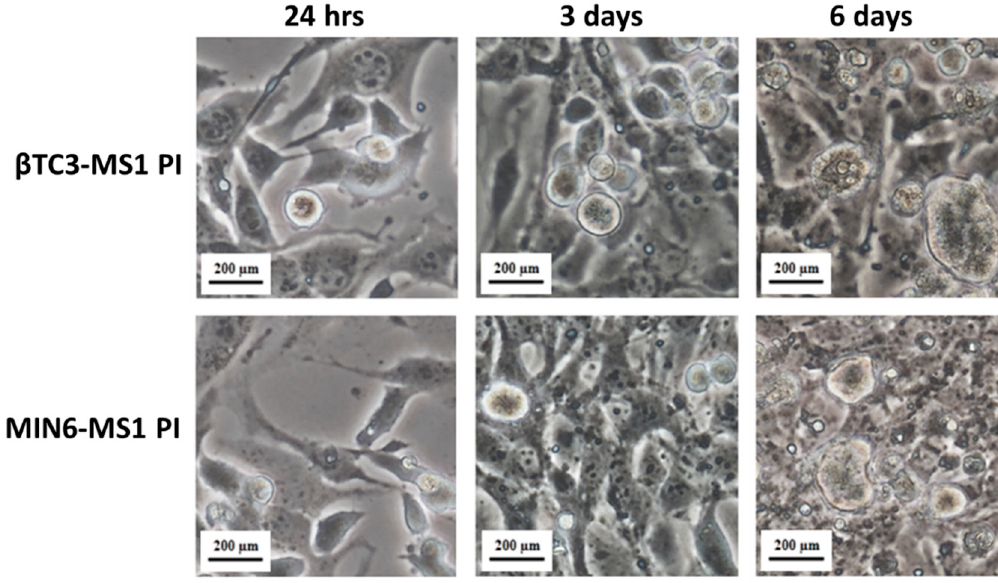
Figure 2. Microscopic view (400-fold magnification) of pseudoislets (PIs) formed from adherent β TC3 or MIN6 insulinoma cells mixed with MS1 pancreatic endothelial cells, after 24 h, three and six days of co-culture.